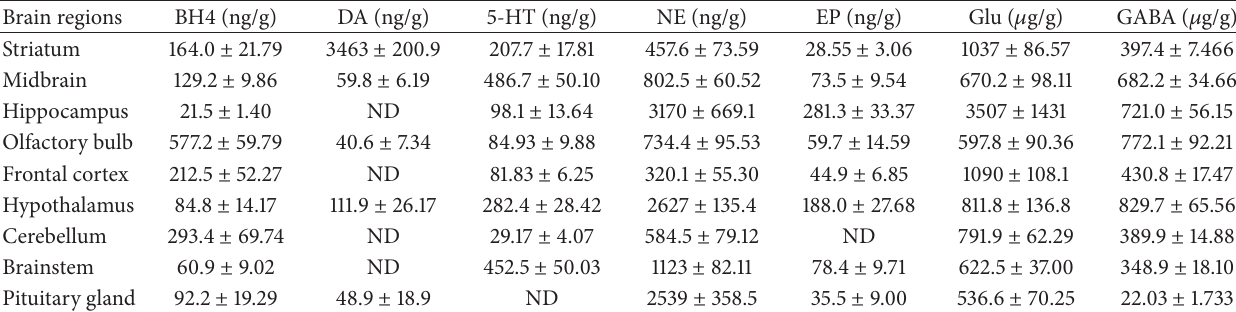
Table 4: The levels of tetrahydrobiopterin (BH4) and neurotransmitters in mouse brain